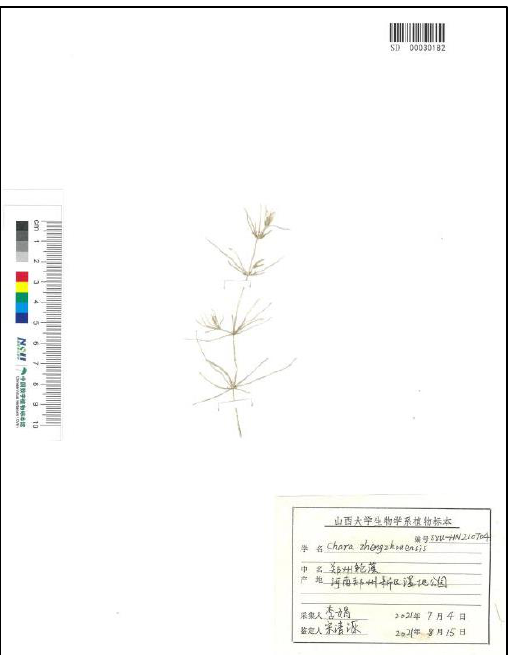
Figure 2. Herbarium specimen of Chara zhengzhouensis from Henan, China (deposited in SXU herbarium). Prepared and scanned by Q. Y. Song.